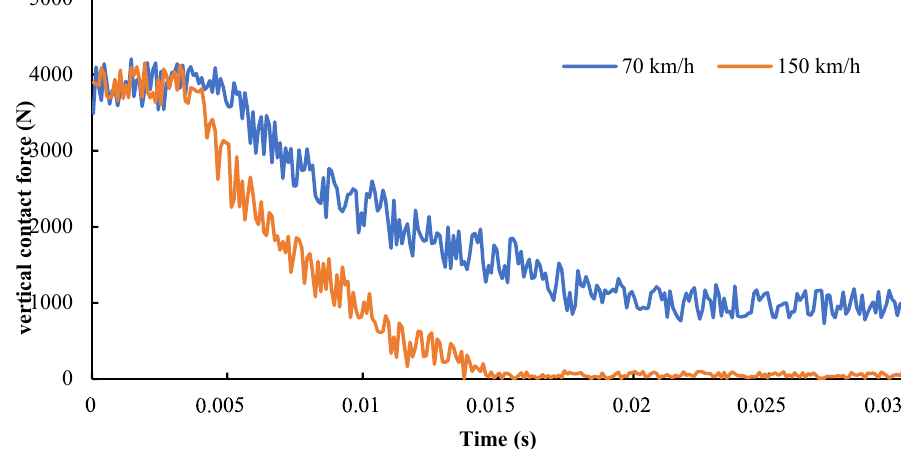
Figure 18. Vertical contact force in the tire aquaplane process.